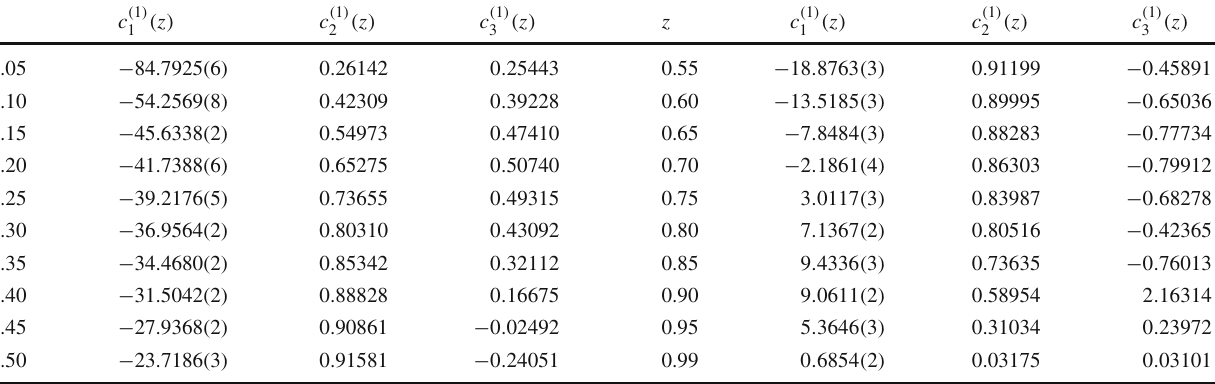
Table 1 Numerical values of non-logarithmic color-singlet coefficient functions c ( 1 ) ( 1 ) ( z ) should be multiplied by an extra factor 10 − 2 of c i